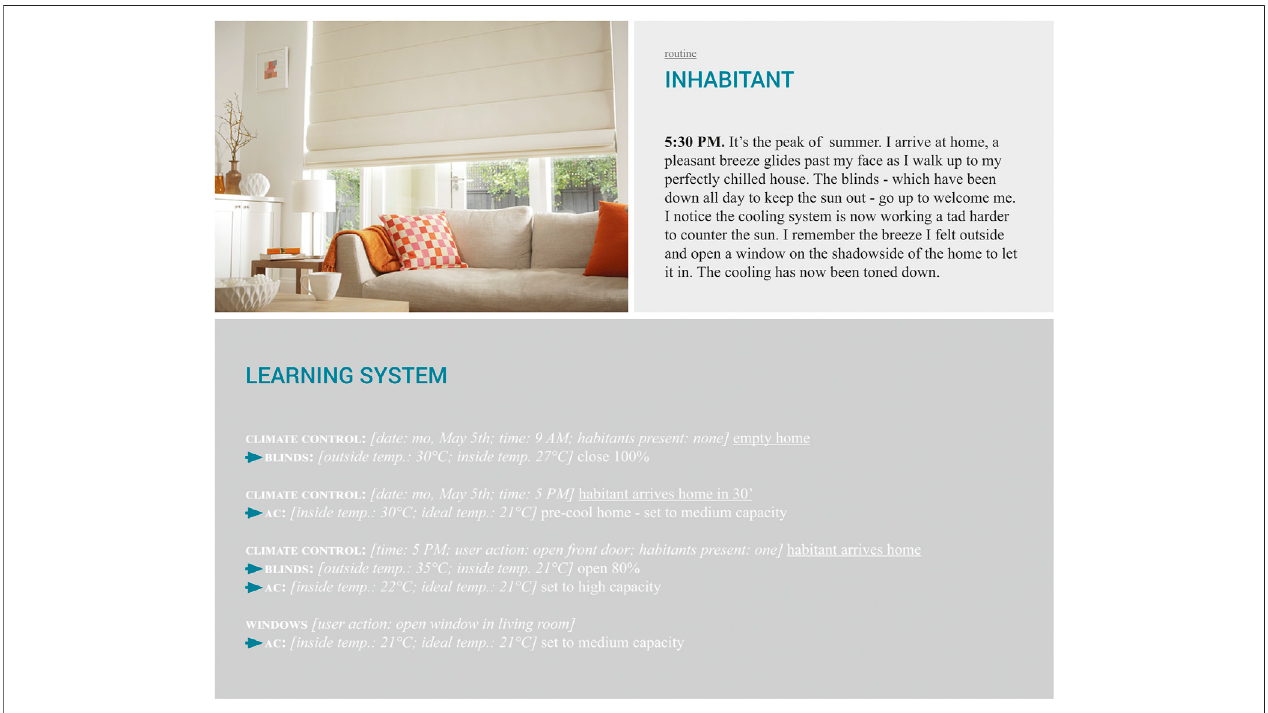
FIGURE 5 | Heating and cooling: routine imaginary (photo by Bunnings,